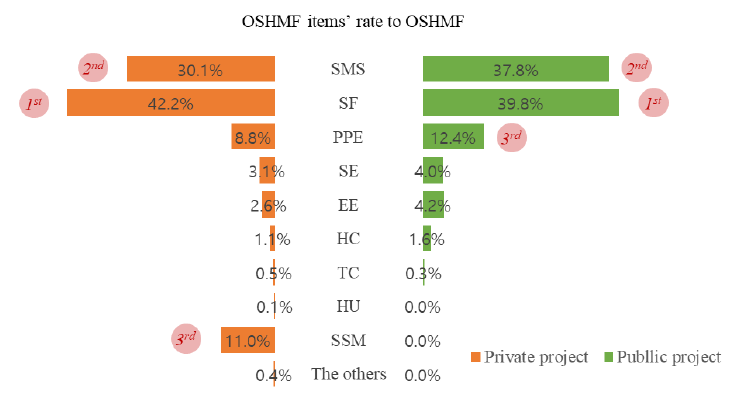
Figure 7. Rates of OSHMF items to OSHMF for different client types.